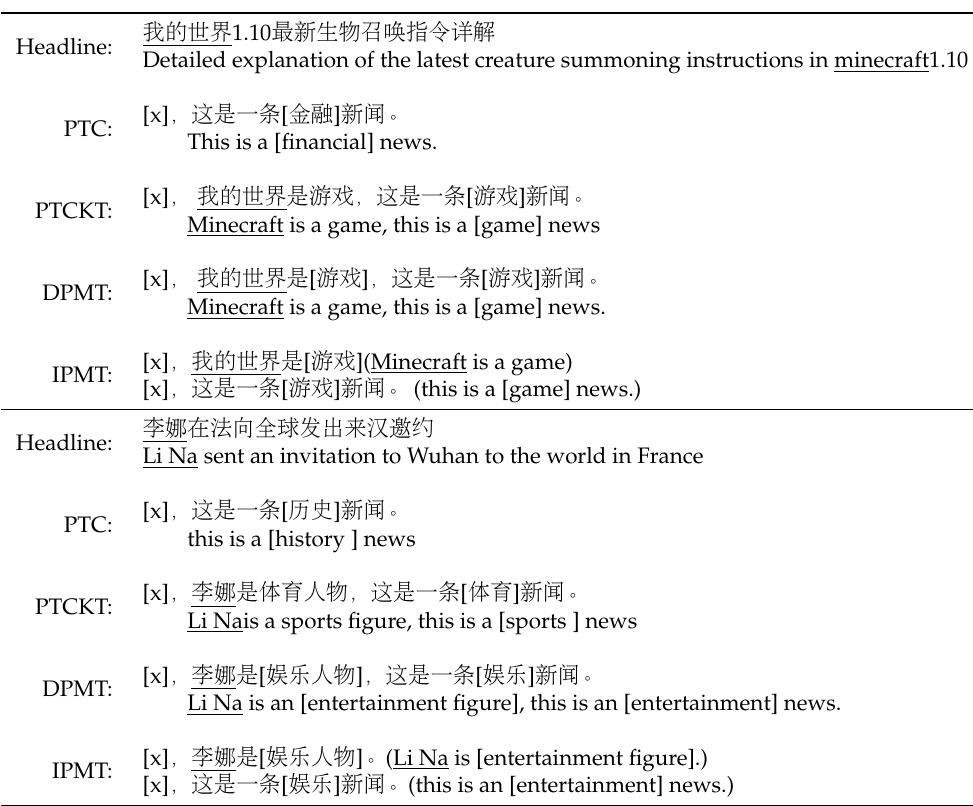
Table 5. Two examples from the data. Underlined phrases are the entities, and the class labels of these examples are game and sports, respectively. [x] represents the headline, and other parenthetical text is the words predicted by the